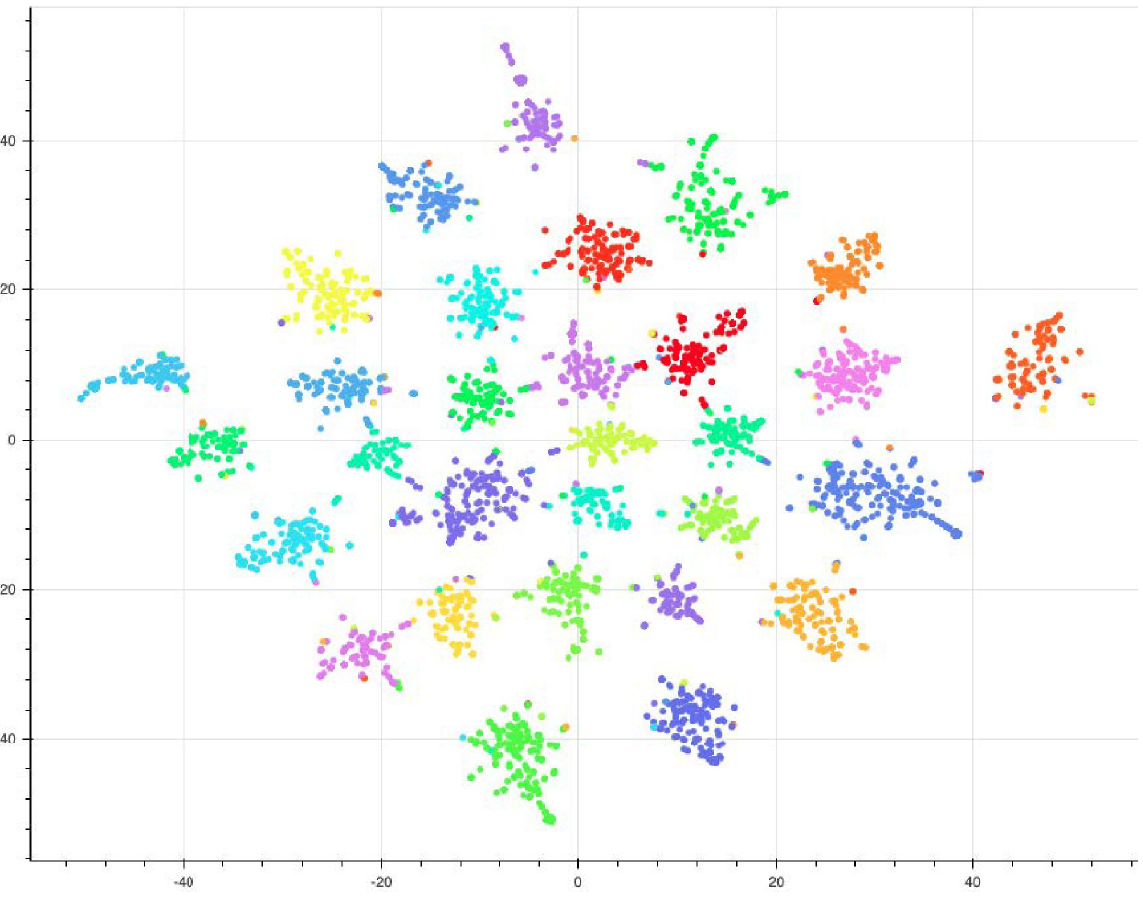
Fig 10. t-SNE sample clustering